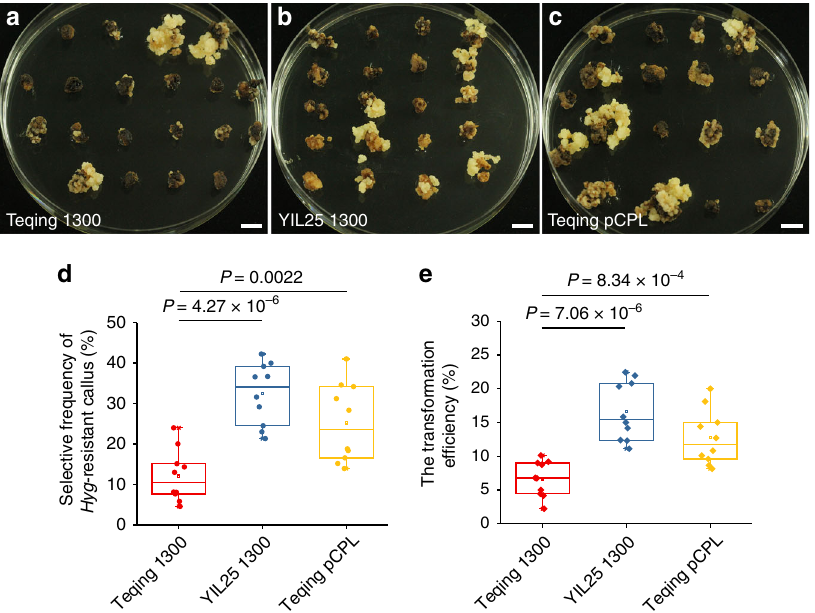
Fig. 5 BOC1 in fl uences genetic transformation ef fi ciency. a – c Transformed calli after three rounds of selection on Hyg- resistant UINB medium. Scale bars, 1 cm. d Comparison of the selection frequency of Hyg -resistant callus. Each dot represents the selective frequency of Hyg -resistant callus of 10 independent experiments. ( e ) Comparison of the transformation ef fi ciency. Each diamond represents the transformation ef fi ciency of 10 independent experiments. Teqing 1300, Teqing calli were infected with Agrobacterium harboring the binary pCAMBIA1300 empty vector as a control. YIL25 1300, YIL25 calli transformed with the binary vector pCAMBIA1300. Teqing pCPL, Teqing calli infected with Agrobacterium harboring the pCAMBIA1300- BOC1 construct. The hollow box in each column in ( d , e ) represents the means of the selective frequency of Hyg -resistant callus and the transformation ef fi ciency of 10 replicates, respectively. Box edges represent the 0.25 and 0.75 quantiles, with the median values shown by red, blue and yellow lines, respectively. Whiskers extend to data no more than 1.5 times the interquartile range, and the remaining data are indicated by dots. P -values of ( d , e ) were determined by two-tailed Student ’ s t -tests. Source data are provided as a Source Data fi